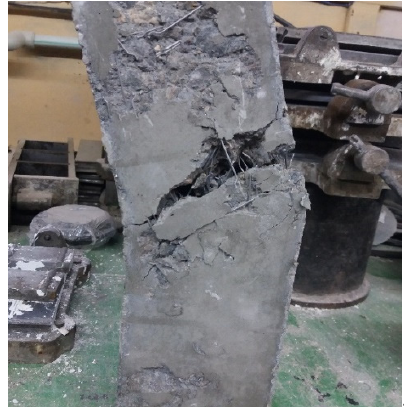
Figure 4. Steel-fiber-reinforced concrete specimen after flexural strength